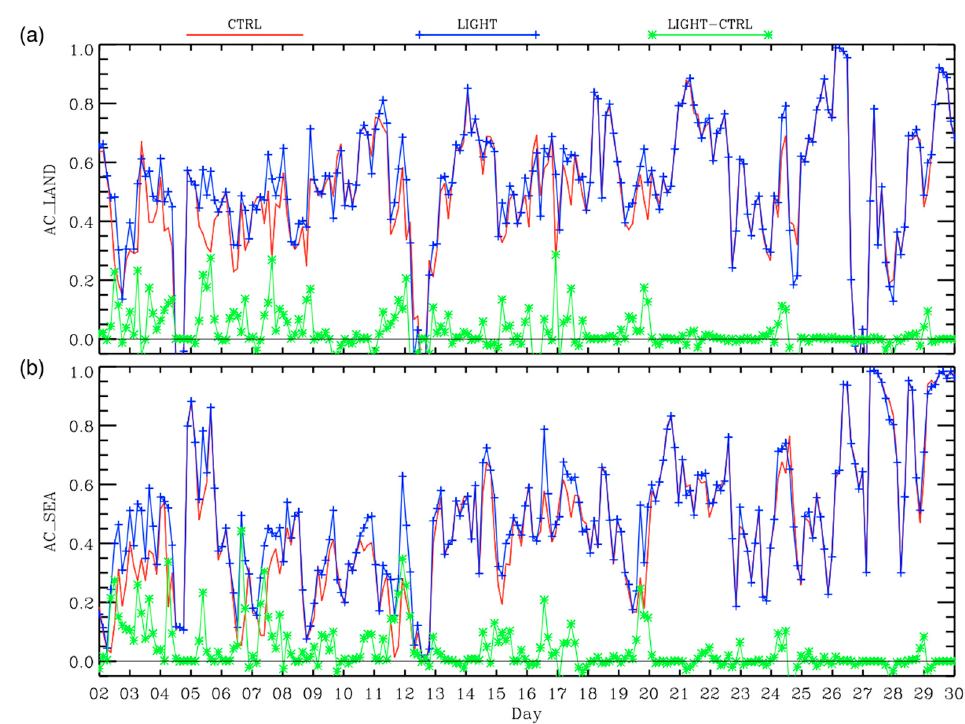
Figure 4. AC of the 3 h precipitation for the whole month of November 2019 for ( a ) land grid points and ( b ) sea grid points. CTRL is in red, LIGHT is in blue, and the difference between LIGHT and CTRL, in this order, is in green. A positive value of the green curve shows a better performance of the LIGHT forecast compared to CTRL.